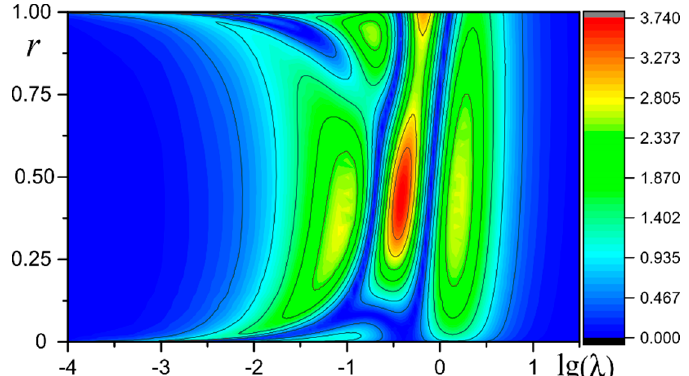
Figure 8. The relative error Δ p ( r , λ ) of the simplified distribution of the contact stresses for β = 0.5 in %.